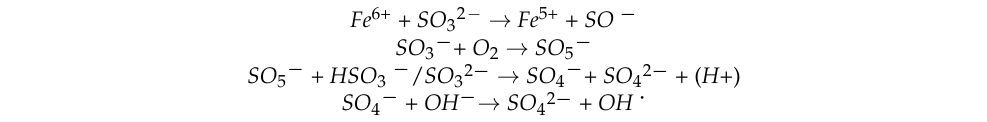
Table 4. Reaction processes involved in forming sulphite radicals in Fe(VI)/sulphite system [21,40,41].